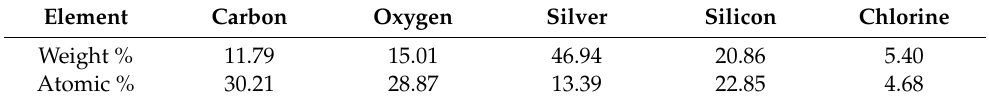
Figure 4. ( a ) FESEM micrograph of AgNPs at 100 nm scale; ( b ) elemental mapping of AgNPs. Table 2. Energy dispersive x ‐ ray spectroscopy (EDX) elemental analysis of AgNPs. Element